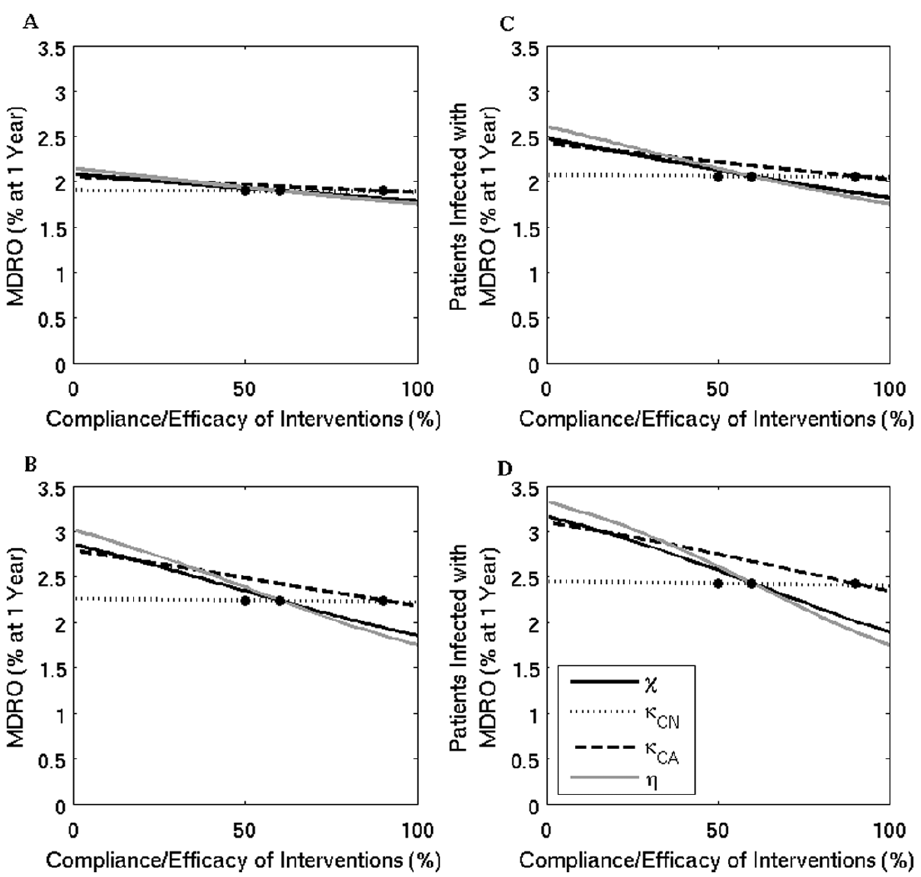
Figure 6. The percent of patients infected with an MDRO at one year when the compliance or efficacy of four interventions are varied for four transmission levels. Solid black line ( x ) - contact precautions, dotted line ( k CN ) - screening of colonized patients not on antimicrobials, dashed line ( k CA ) - screening of colonized patients receiving antimicrobials, and grey line ( g ) - compliance with hand hygiene measures. The dots mark the baseline values. (A) b CA ~ 0 : 2 ; (B) b CA ~ 0 : 4 - baseline value used in other simulations; (C) b CA ~ 0 : 6 ; and (D) b CA ~ 0 : 8 .